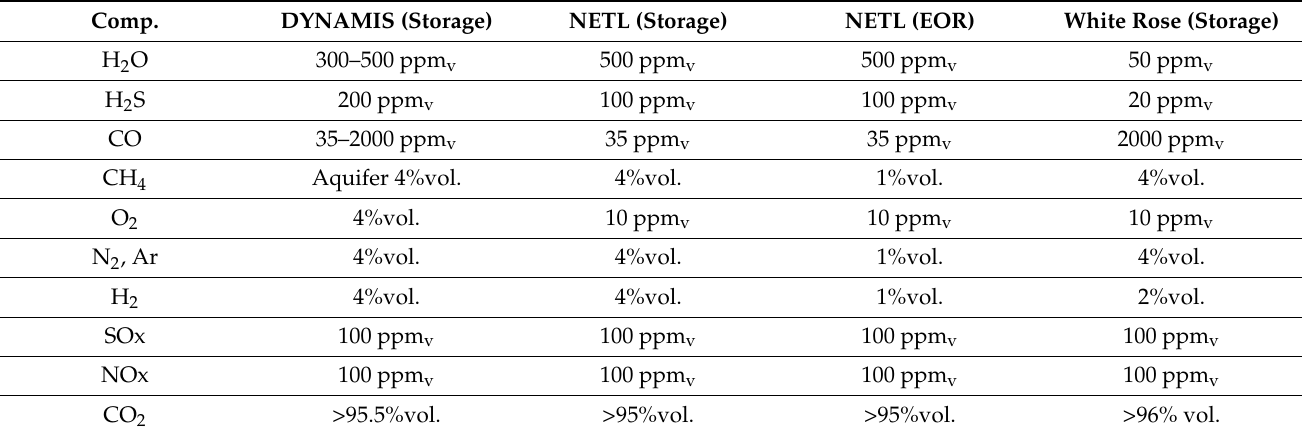
Table 1. Typical CO 2 quality requirements mentioned in the following studies: DYNAMIS [33,34], NETL [35], and White Rose